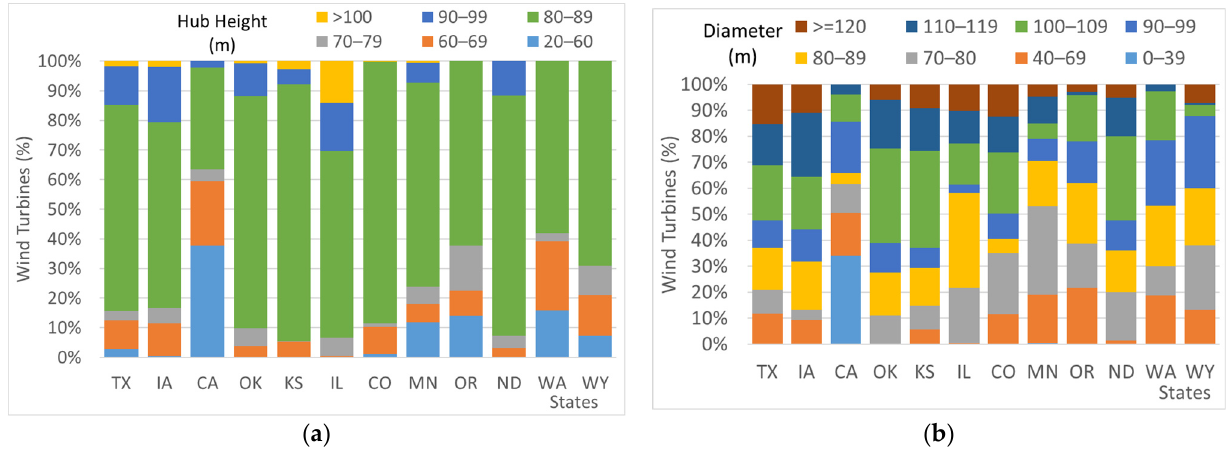
Figure 6. Assessment of ( a ) hub height of wind turbines by state and ( b ) diameter of wind turbines by state.